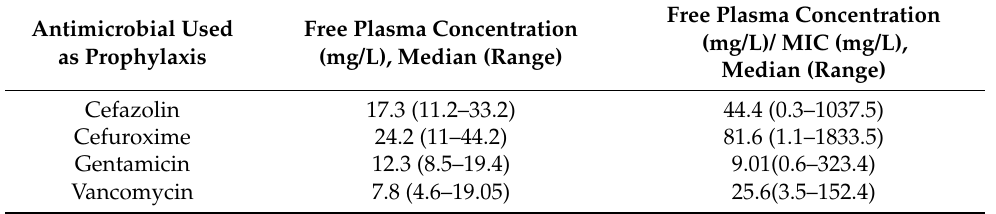
Table 3. Prophylactic plasma antimicrobial levels in culture-positive surgical procedures and ratios of these antimicrobial levels to the minimum inhibitory concentrations (MICs) for bacteria isolated in the surgical